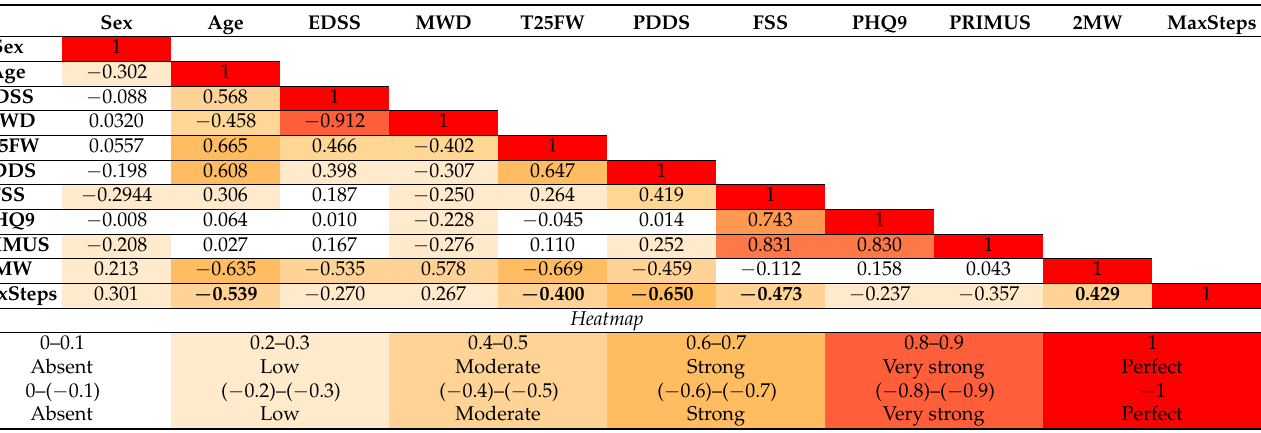
Table 3. Bivariate associations between the maximum value of steps and demographic and clinical variables, both objectively detected and reported by the patient. The heatmap (below) graphically depicts the direction of the correlation, with red tones trending towards a stronger association, negative or positive ( ± 1). Correlations are computed using the Spearman’s